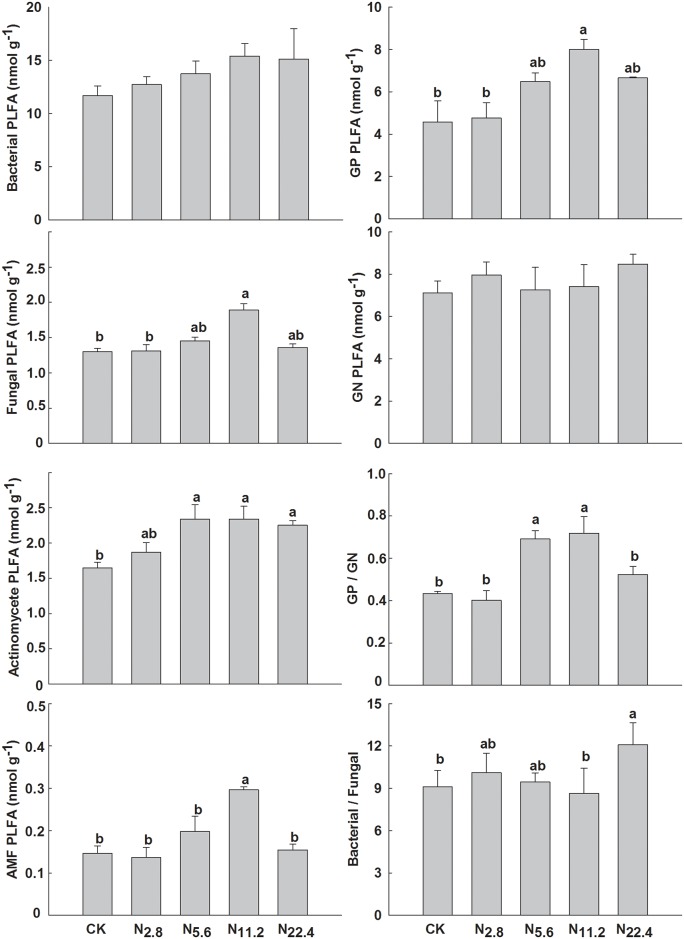
Effect of N addition on phospholipid fatty acid (PLFA) content of different microbial community (mean ± SE).(A) Different letters above bars denote significant difference among treatments (P < 0.05). (B) AMF: arbuscular mycorrhizal fungal, GP: gram-positive bacterial, GN: gram-negative bacterial, GP/GN: GP and GN ratios, Bacterial/Fungal: bacterial and fungal ratios.